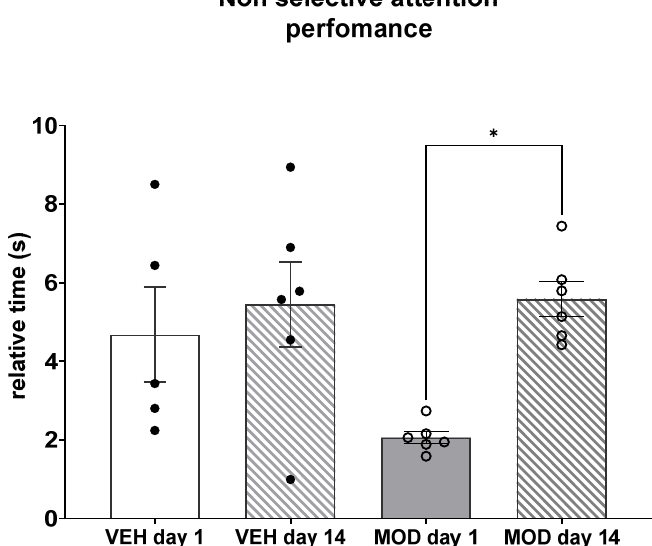
Figure 3. Non-selective attention (NSA) at day 1 and day 14 after vehicle (VEH) or modafinil (MOD) treatment in young male rats in 60 min test. Kruskal–Wallis test followed by Dunn post-hoc was used. Data are presented as the mean ± SEM; n = 5 or 6 per group. * p < 0.05.